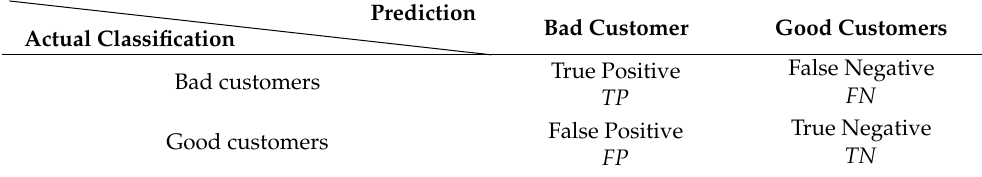
Table 6. Confusion